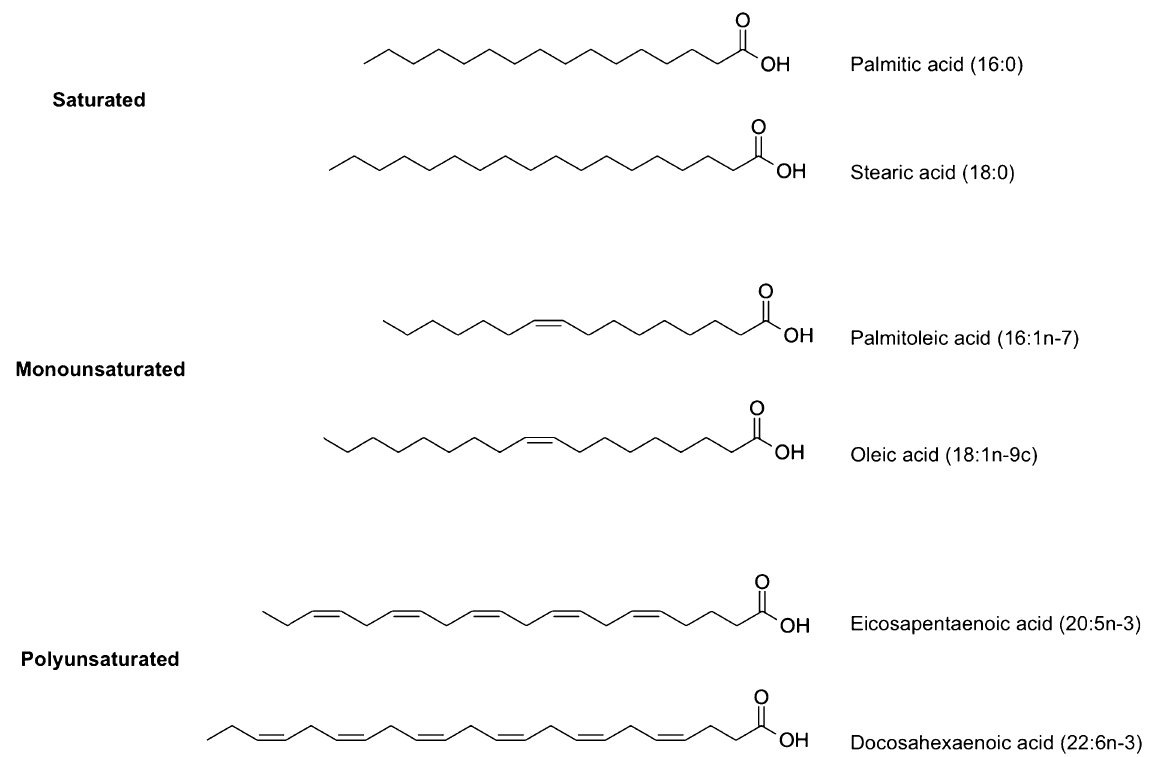
Fig. 1 Examples of saturated, monounsaturated, and polyunsaturated fatty acids found in intertidal biofilm (Schnurr et al. 2019,